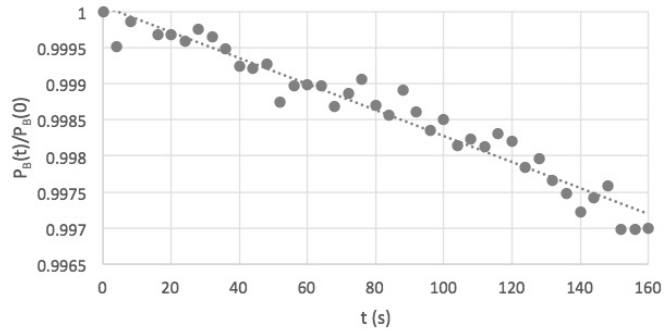
Figure 9. The variation in intensity of images of a DPA solution during a dummy 40 image scan without appreciable movement of the stage using the default standby mode of operation with pulsed UV illumination.